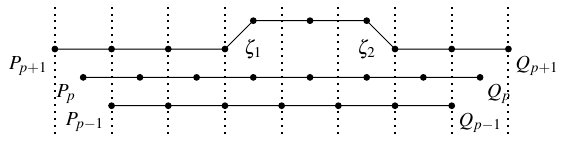
Figure 5: The single type of ( p + 1 ) -collection with one ascent and one descent, with the zones of the ascent and descent marked